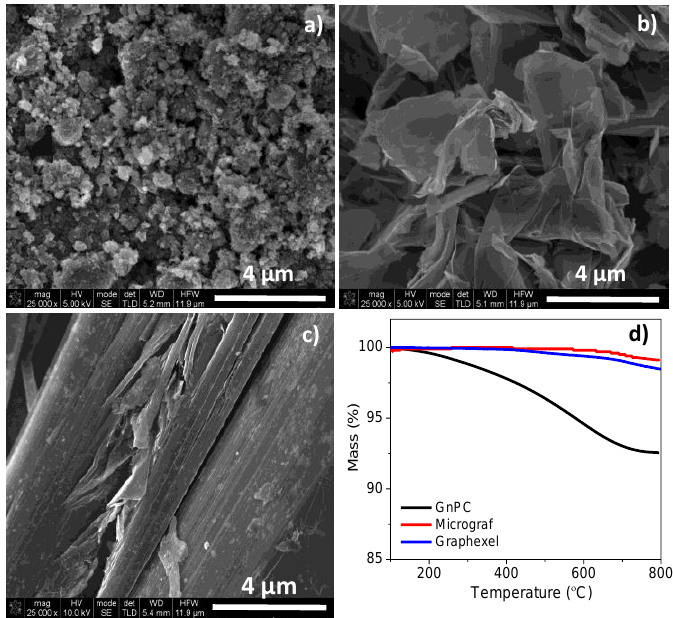
Figure 1. ( a – c ) Scanning electron microscopy (SEM) images and ( d ) thermogravimetric analysis of the Figure 1. (a – c) Scanning electron microscopy (SEM) images and (d) thermogravimetric analysis of the GnPC, Micrograf, and Graphexel starting materials, GnPC, Micrograf, and Graphexel starting materials, respectively.